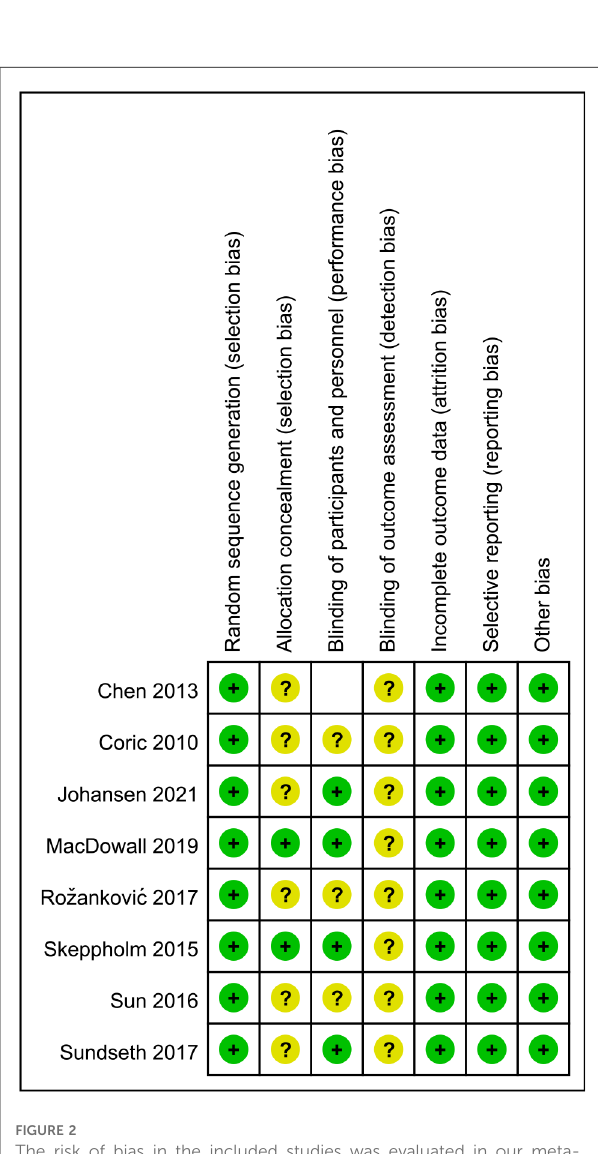
FIGURE 2 The risk of bias in the included studies was evaluated in our meta-